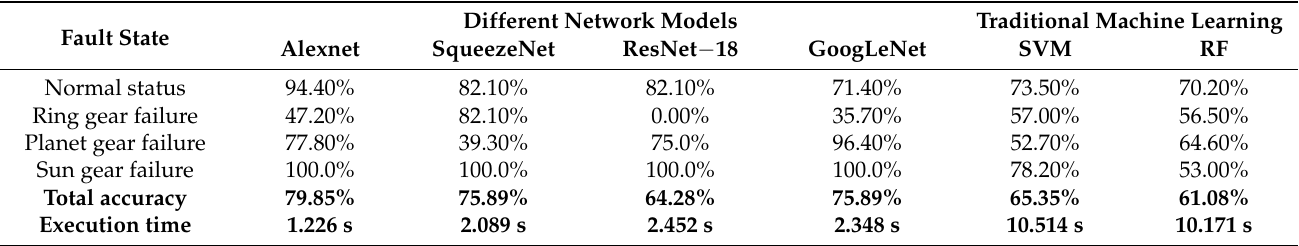
Table 7. Comparative analysis of fault diagnosis between different network models and traditional methods when CR =